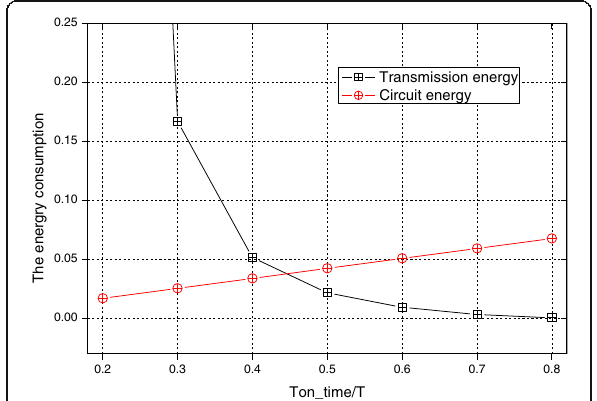
Fig. 8 The energy consumption of transmission and circuit at s